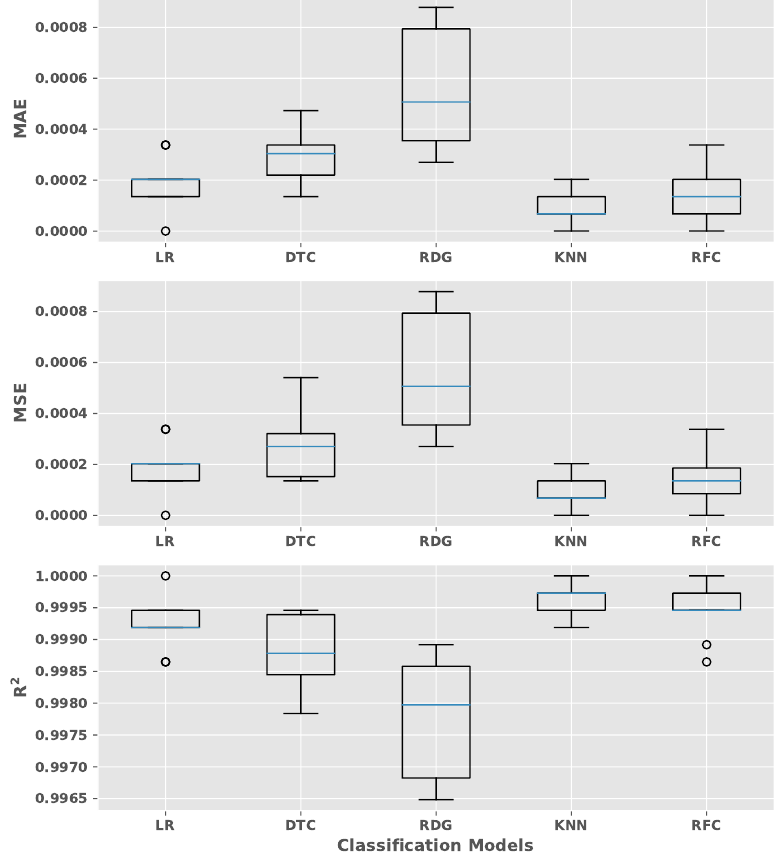
Figure 7. An algorithm comparison with cross-validation method with 10 folds. The mean absolute error (MAE), mean squared error (MSE), and the coefficient of determination ( R 2 ) of different algorithms are shown.